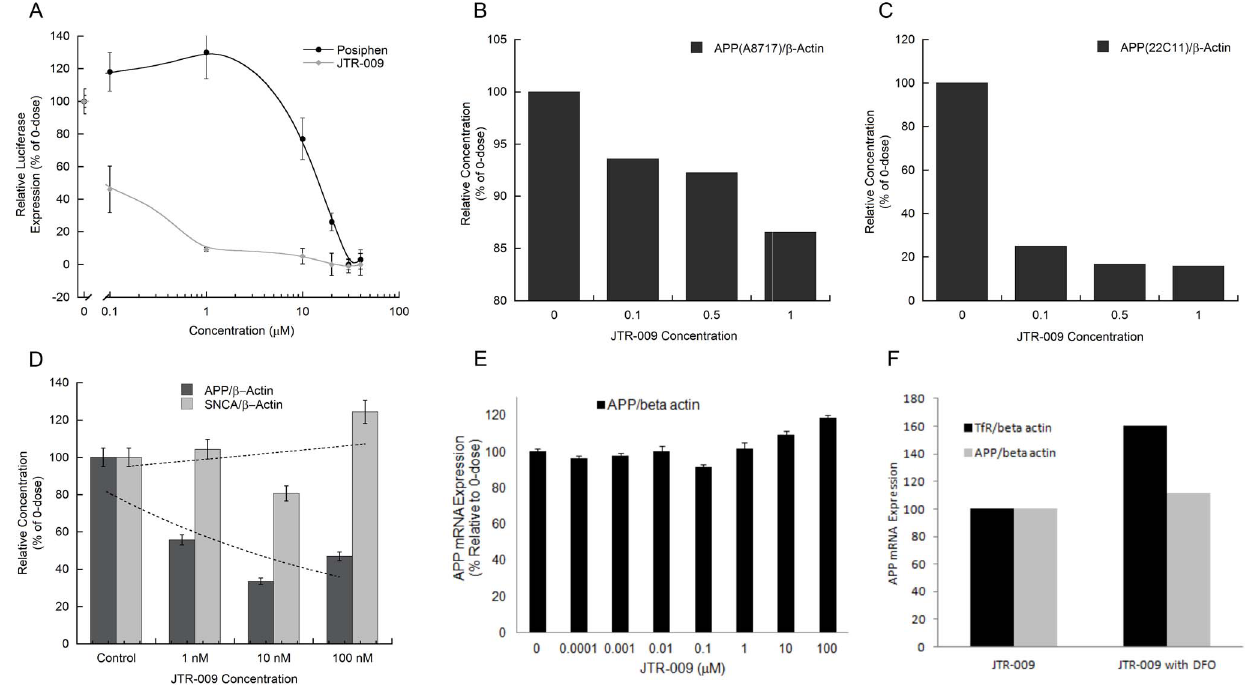
Figure 4. Evaluation of the potency and selectivity of APP blocker-9. Panel A : Dose responsive measurement of the capacity of JTR-009 to limit APP 5 9 UTR-luciferase expression relative to posiphen, a known APP translation blocker (JTR-009: IC 50 =0.1 m M; posiphen: IC 50 =5 m M, N=4). Panel B : Dose-responsive reduction APP levels in SH-SY5Y cells treated 48 hours at 0.1 m M, 0.5 m M and 1 m M JTR-009. Western blot for APP levels using N- terminal 22C11 antibody (standardization with b -actin as loading control). Bottom Panel: Histogram quantitation of the relative expression of APP/ b -actin in SH-SY5Y cells. Panel C : Lysates from the experiment in Panel B was analyzed by Western blotting using APP the C-terminal specific (A8717) antibody and b -actin antibody. Bottom Panel: histogram quantitation of the relative expression of APP/ b -actin in SH-SY5Y cells from autoradiographic film subjected to densitometry (N=3). Panel D : Dose-responsive capacity of JTR-009 to limit APP expression in primary E-18 mouse neurons (1 nM). The relative a -synuclein ( SNCA ) expression was calculated. Shown, the combined data was graphed into a histogram where mean values from separate assays were calculated from densitometry of Western blots (N=5). Panel E : Real-time qPCR measurement of the dose- responsive measurement of the levels of APP mRNA in SH-SY5Y cells treated with escalating concentrations of JTR-009 for 48 hours. Panel F